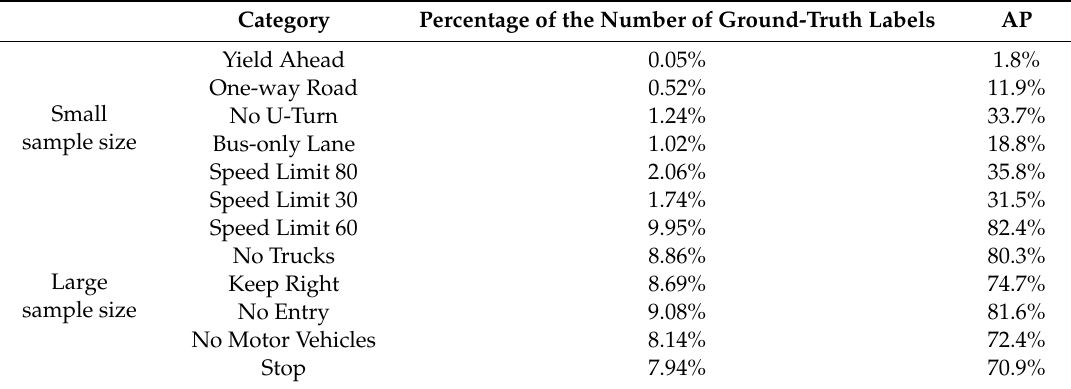
Table 2. Recognition accuracy of baseline for some